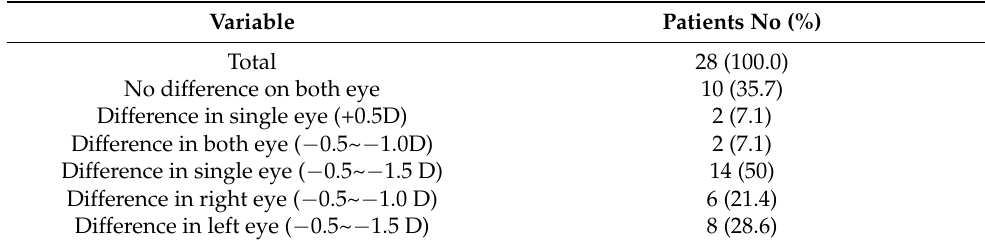
Table 4. Intraocular lens power difference (using the Hoffer Q, SRK-2, and SRK/T formulas) between pre-and post-methimazole treatment of Graves’ disease